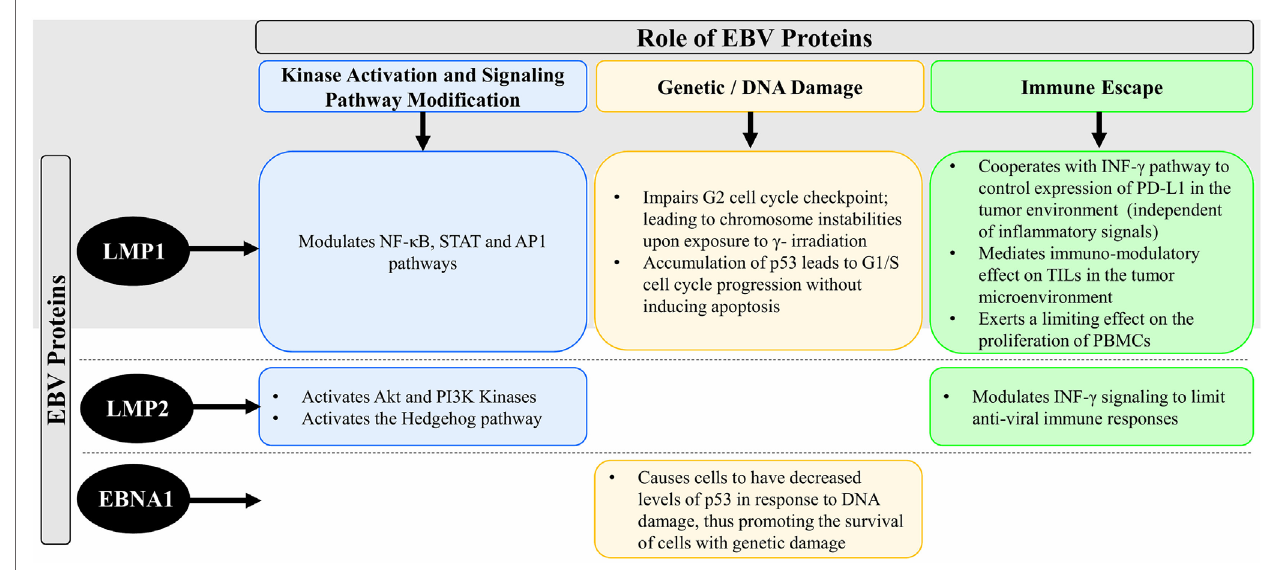
FiGURe 1 | Schematic diagram comparing the role of the EBV proteins (LMP1, LMP2, and EBNA1) in the oncogenic pathogenesis and/or the immune escape of NPC. Abbreviations: EBV, Epstein–Barr virus; LMP1, latent membrane protein 1; LMP2, latent membrane protein 2; EBNA1, EBV-induced nuclear antigen 1; NF- κ B, nuclear factor kappa-light-chain-enhancer of activated B cells; STAT, signal transducer and activator of transcription; AP1, activator protein 1; Akt, protein kinase B; PI3K, phosphatidylinositol-4,5-bisphosphate 3-kinase; p53, cellular tumor antigen p53; INF- γ , interferon-gamma; TILs, tumor-infiltrating lymphocytes; PD-L1, programmed cell death protein 1 ligand; PBMCs, peripheral blood mononuclear cells; DNA, deoxyribonucleic acid; NPC, nasopharyngeal